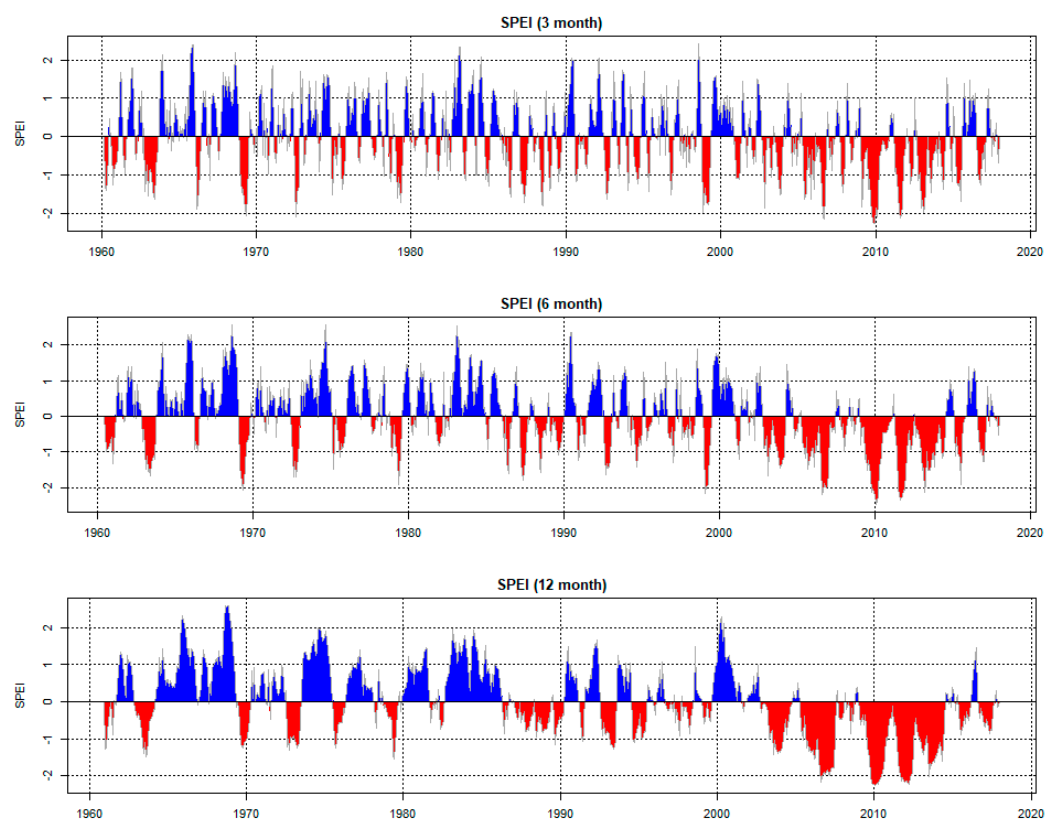
Figure 3. Time series of the Standardized Precipitation Evapotranspiration Index (SPEI) with 3-, 6-, and 12-month timescales in Southwest China.